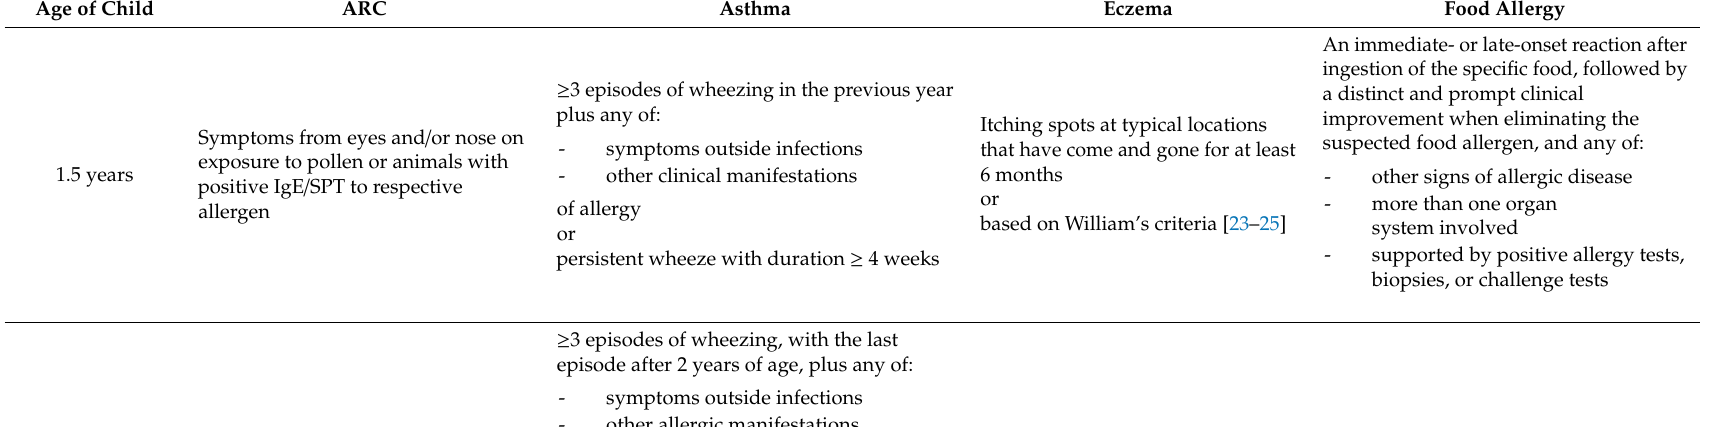
Table 2. Diagnostic criteria for airway rhinoconjunctivitis (ARC), asthma, eczema, and food allergy at 1.5, 3, and 8 years of age in the FARMFLORA study. Age of